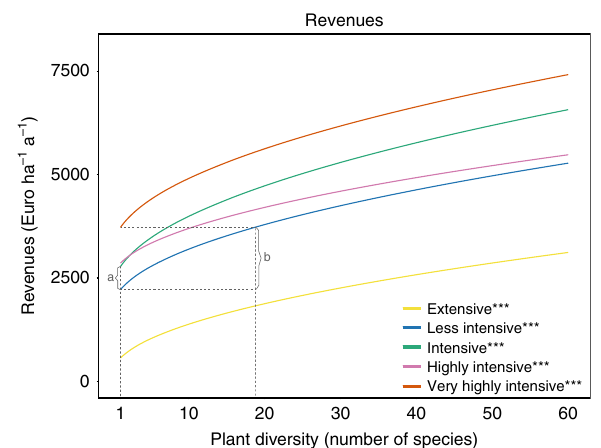
Fig. 6 Predicted revenues as a function of plant diversity and management intensity. ( a ) indicates the effect size of changing management intensity from less intensive to intensive, or changing plant diversity in the less intensive management from 1 to 5 species. ( b ) indicates the effect size of changing the management intensity from less intensive to the very highly intensive, or changing plant diversity in the less intensive management from 1 to 19 species.*, **, *** denote signi fi cance at the 5%, 1%, and 0.1% level of the plant diversity effect per management intensity, respectively (corrected for multiple comparisons). The signi fi cance levels are based on a mixed effect model, see Eq. (4). The corresponding coef fi cients for the plant diversity effect per management intensity can be found in Supplementary Table 6. Source data are provided as a Source Data fi